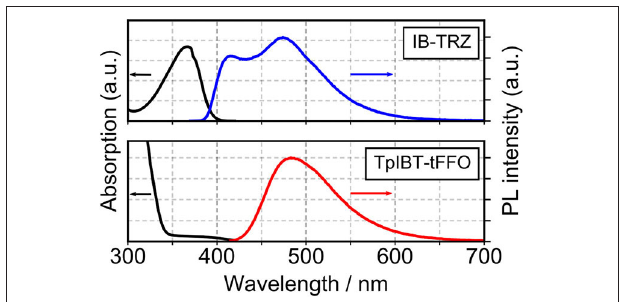
FIGURE 4 | UV-vis absorption (black) of TpIBT-tFFO and IB-TRZ and the PL spectra of TpIBT-tFFO (red) and IB-TRZ (blue) in a toluene solution (10 − 4 M).